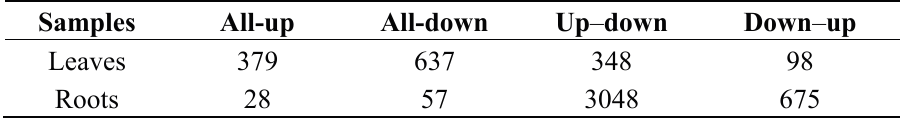
Table 2. Numbers of unigenes with different expression patterns in leaves and roots during drought